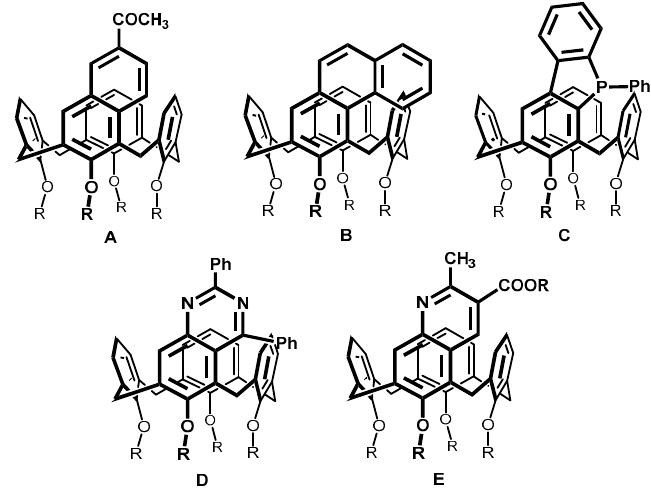
Figure 2. Examples of calix[4]arenes with fused rings.